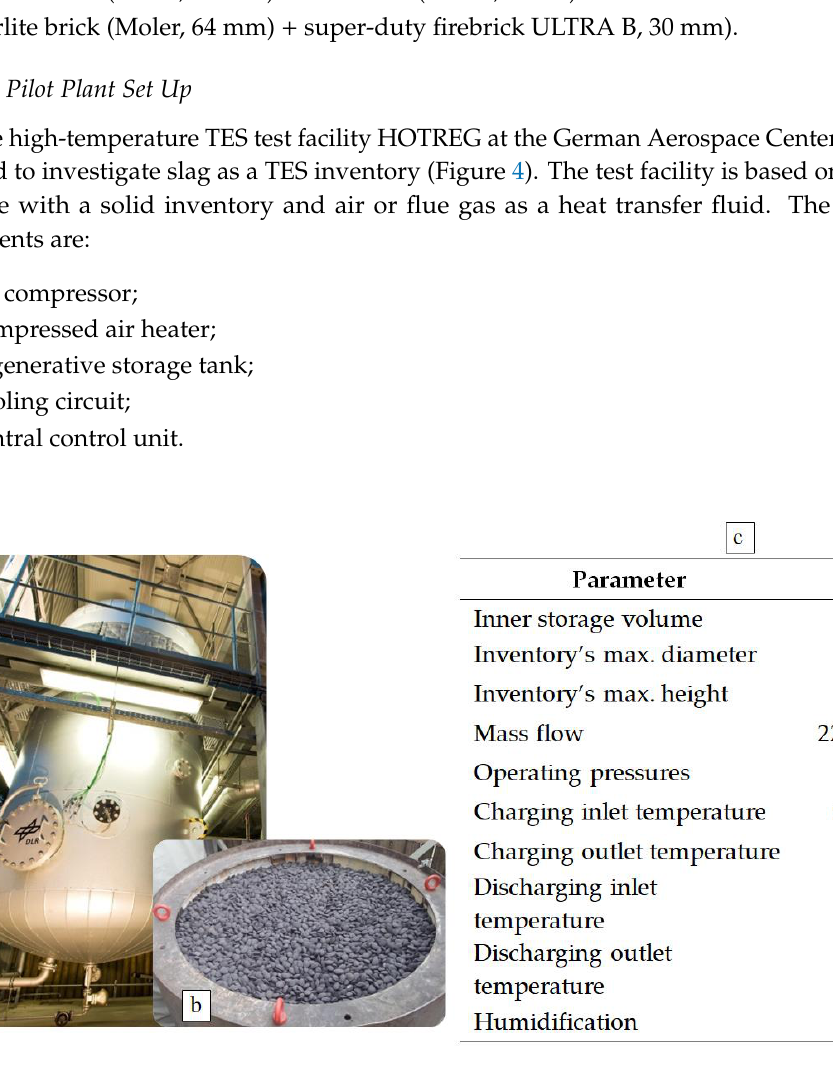
Figure 4. High-temperature thermal energy storage (TES) test facility HOTREG ( a ); test setup for slag-based TES ( b ) and basic specifications of HOTREG ( c ) [27].